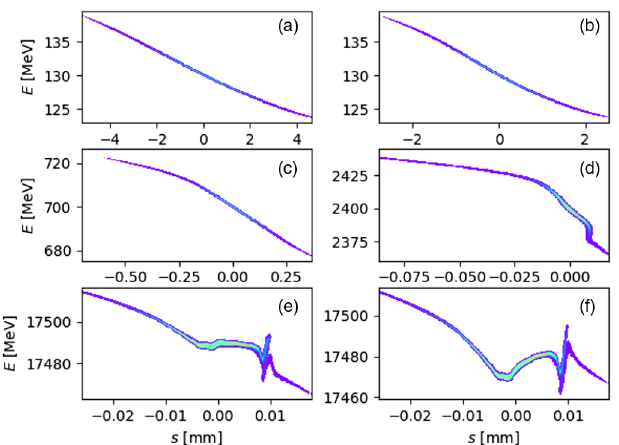
FIG. 11. Snapshots of the longitudinal phase space of the bunch with a charge of 250 pC compressed to 10 kA peak current: (a) after the injector dogleg, (b) after BC 1 , (c) after BC 2 , (d) after BC 3 , (e) after the main linac, and (f) after the collimator